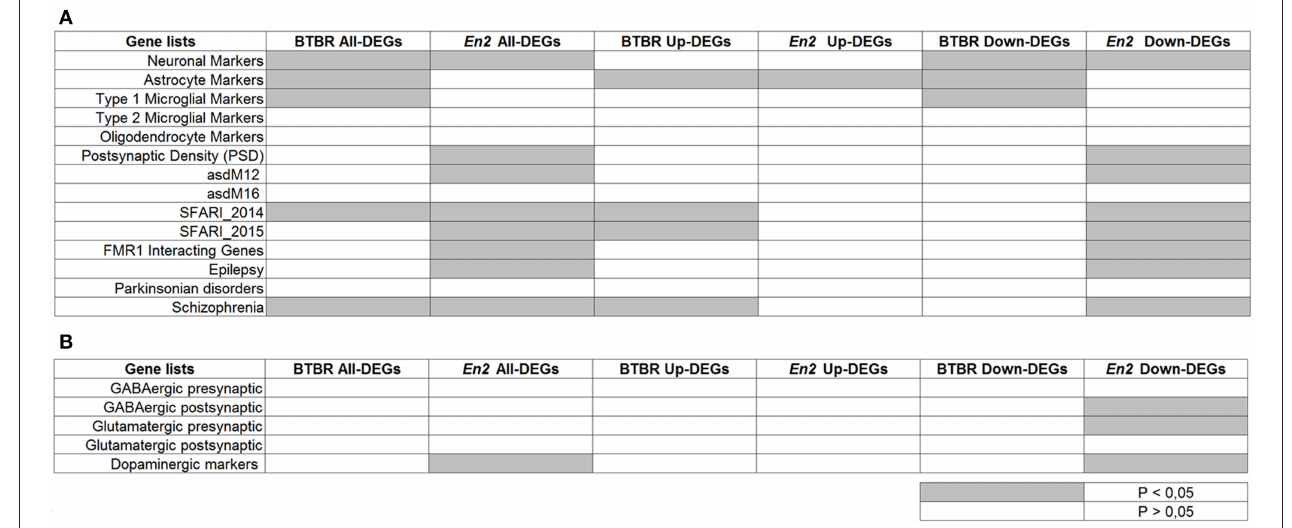
FIGURE 5 | Enrichment analysis on BTBR and En2 − / − hippocampal DEGs. Lists of BTBR and En2 − / − hippocampal DEGs (all, up-regulated and down-regulated) were analyzed for enrichment in genes belonging to specific categories relevant to the autistic phenotype (A) and neuronal subtypes (B) . Gene lists were compiled from the literature (see Materials and Methods and references therein). Significance of enrichment is indicated (white, p > 0.05; gray, p < 0.05).